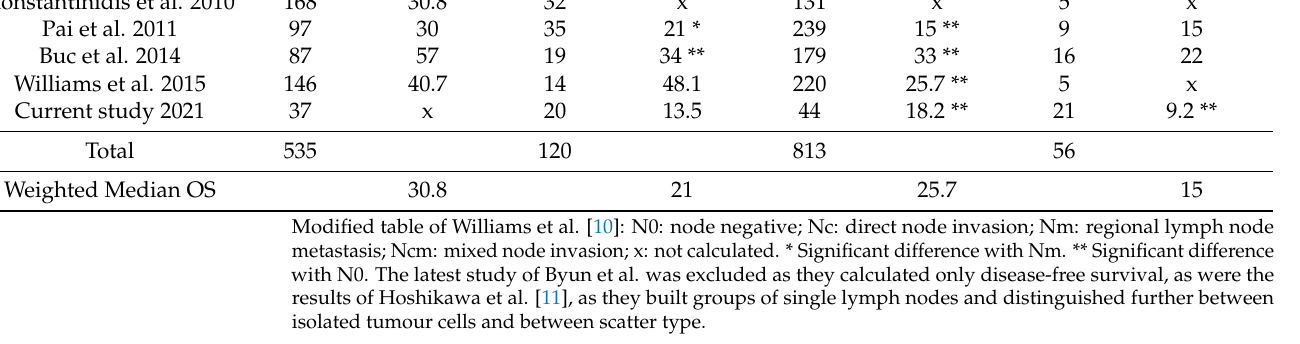
Table 4. Overall survival of lymph node types of the latest studies.